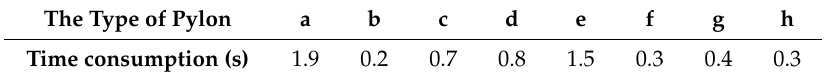
Table 11. The efficiency of pylon reconstruction. Table 11. The e ffi ciency of pylon